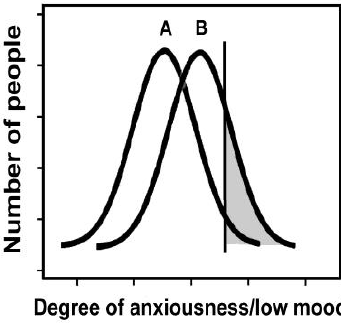
Figure 1. Theoretical distribution of fear and low mood. Above a more or less arbitrary cut-off (grey), the conditions are diagnosed as anxiety and depression, respectively. In an optimal environment (A), such as an ideal Stone Age situation, fewer people would be above the cut-off; while in a less healthy environment (B), which may include typical industrialized nations, more people suffer from these